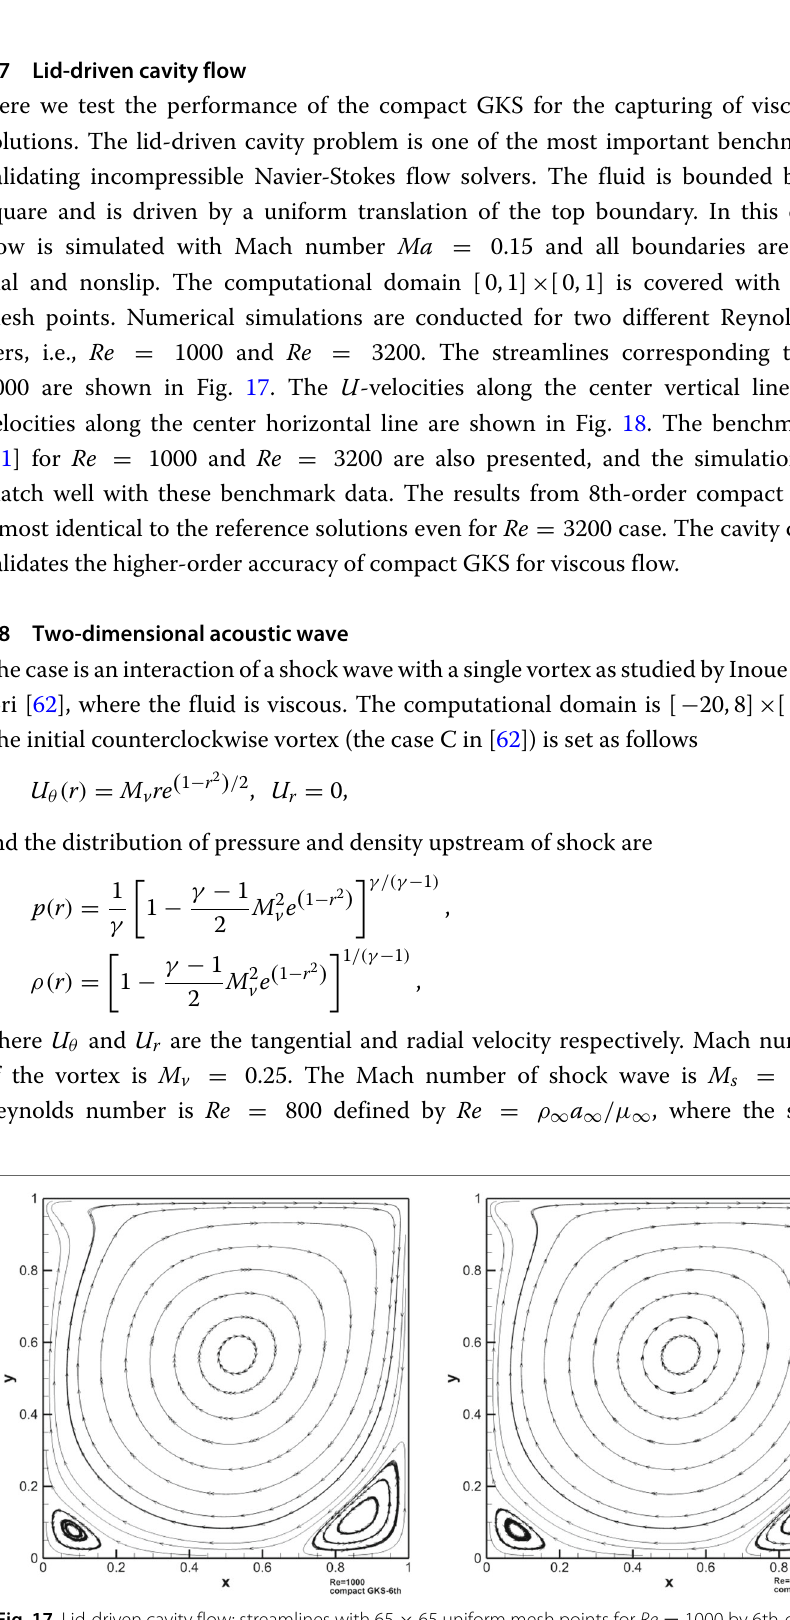
Fig. 17 Lid-driven cavity flow: streamlines with 65 × 65 uniform mesh points for Re = 1000 by 6th-order